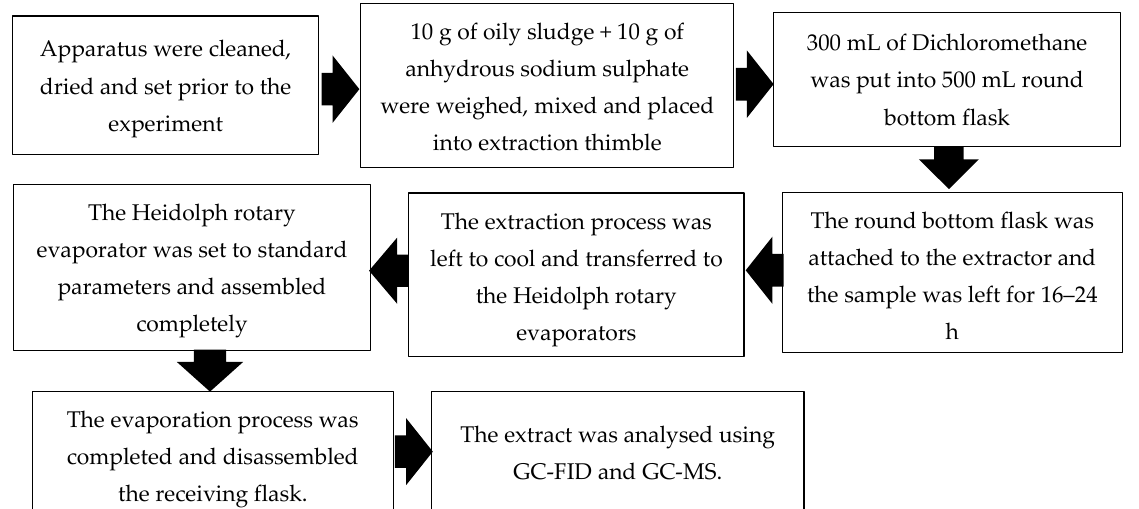
Figure 2. Process flowchart for the determination of petroleum hydrocarbons.